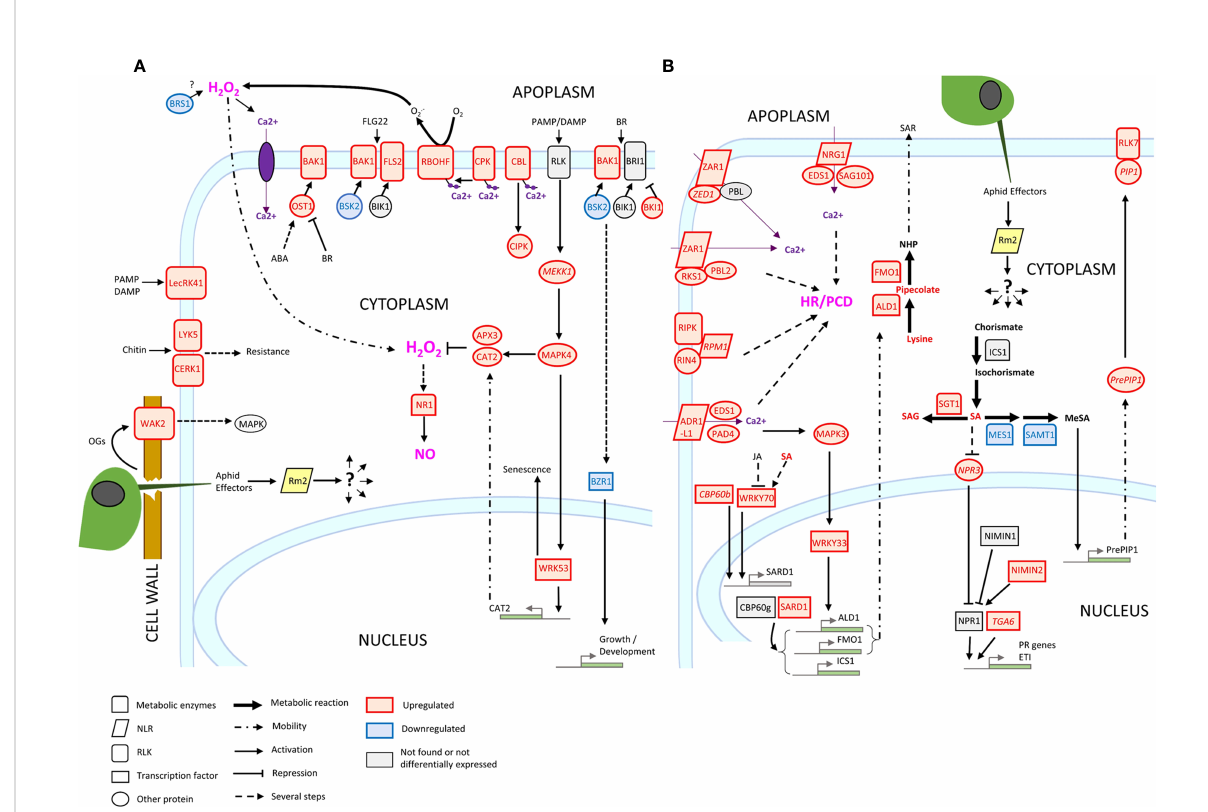
FIGURE 6 Transcriptional regulation of ETI, PTI, HR and SAR in Rubira 48 hours after infestation with GPA. (A) PTI genes. (B) ETI genes. Genes are annotated according to their Arabidopsis orthologs, non-orthologs (homologs) are noted in italics. Upregulated genes/metabolites are fi gured in red, downregulated genes/metabolites in blue and not found or not differentially expressed genes/metabolites in black. BIK1, Botrytis induced kinase 1; BRI1, Brassinosteroid insensitive 1; ICS1, Isochorismate synthase 1; NPR1, Nonexpresser of PR genes 1; OST1, Open stomata 1; RIN4, RPM1- interacting protein 4; RPM1-induced protein kinase; Disease resistance protein RPM1; PCD, programmed cell death; ADR1-LIKE 1, Activated disease resistance 1 like 1; ALD1, AGD2-like defense response protein 1; APX3, Ascorbate peroxidase 3; BAK1, Brassinoid insensitive 1-associated receptor kinase 1; BKI1, BRI1 kinase inhibitor 1; BRS1, BRI1 suppressor; BSK2, Brassinosteroid-signalling kinase 2; BZR1, Protein BRASSINAZOLE-RESISTANT 1; CAT2, Catalase 2; CBL10, Calcineurin B-like protein 10; CBP60B, Calmodulin-binding protein 60 B; CERK1, Chitin elicitor receptor kinase 1; CIPK25, CBL-interacting serine/threonine-protein kinase 25; CPK12, Calcium-dependent protein kinase 12; EDS1, Enhanced disease susceptibility 1; FLS2, Flagellin sensitive 2; FMO1, Probable fl avin-containing monooxygenase 1; LECRK41, L-type lectin-domain containing receptor kinase IV.1; LYK5, LysM-containing receptor-like kinase 5; MEKK1, Mitogen-activated protein kinase kinase 1; MES1, Methyl esterase 1; MPK3, Mitogen-activated protein kinase 3; MPK4, Mitogen-activated protein kinase 4; NIMIN1, NIM1-interacting 1; NIMIN2, NIM1-interacting 2; NPR3, NPR1-like protein 3; NRG1, Probable disease resistance protein; PAD4, Lipase-like PAD4; PIP1, PAMP-induced secreted peptide 1; RBOHF, Respiratory burst oxidase homolog protein F; RLK7, Receptor like protein kinase 7; SAG101, Senescence associated gene 101; SAMT1, S-adenosylmethionine transporter 1; SARD1, Protein SAR de fi cient 1; SGT1, Salicylic acid glucosyltransferase 1; TGA6, TGACG motif-binding factor 6; WKRY33, Transcription factor WKRY33; WRKY53, Transcription factor WKRY53; ABA, Abscisic acid; SA, Salicylic acid; SAG, Salicylic acid glucoside; OGs, oligogalacturonides; PAMP, Pathogenesis-associated molecular pattern; DAMP, Damage-associated molecular